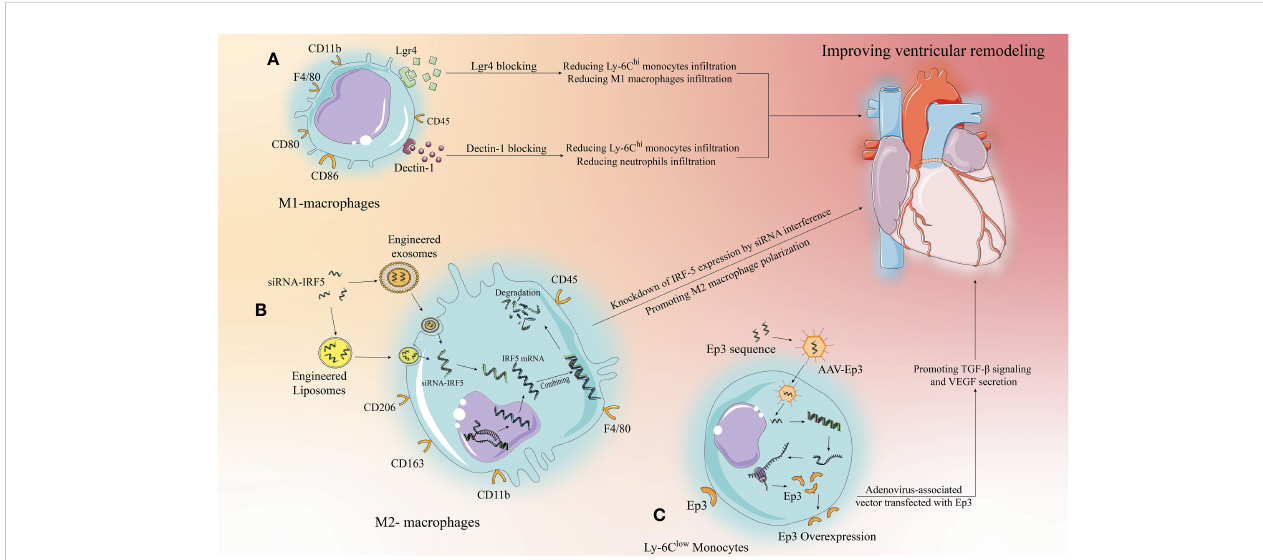
FIGURE 3 Targeting strategies for the development of new immunomodulatory therapies with immune cells. Monocytes/macrophages are used as an example for illustration, we propose three targeting strategies. (A) Extracellular speci fi c blockade of surface receptors based on preclinical studies to modulate relevant signaling pathways to modify the in fl ammatory response and improve ventricular remodeling. (B) Liposomes and exosomes as drug carriers can effectively target macrophages and be phagocytosed by macrophages to release the drug. siRNAs designed to target and inhibit relevant target proteins can enter macrophages via liposomes or exosomes to knock down the expression of pro-in fl ammatory target proteins, thereby altering the in fl ammatory microenvironment to improve ventricular remodeling. (C) AAV has been developed rapidly in recent years, with low toxicity and strong targeting. Designing anti-in fl ammatory target protein sequences to be loaded by AAV to target and increase the expression of anti-in fl ammatory target proteins in target cells, thereby inhibiting in fl ammation and improving ventricular